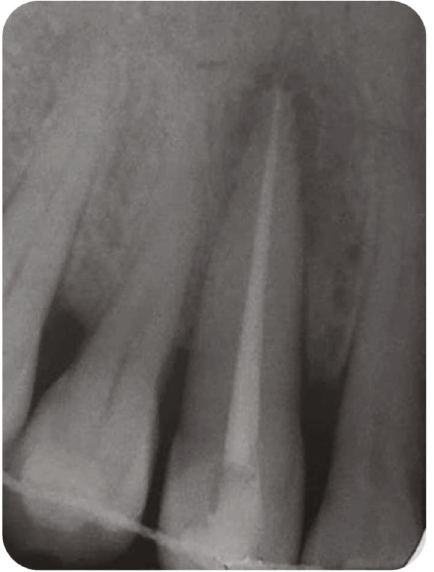
Figure 12: 18 months ’ recall radiograph.